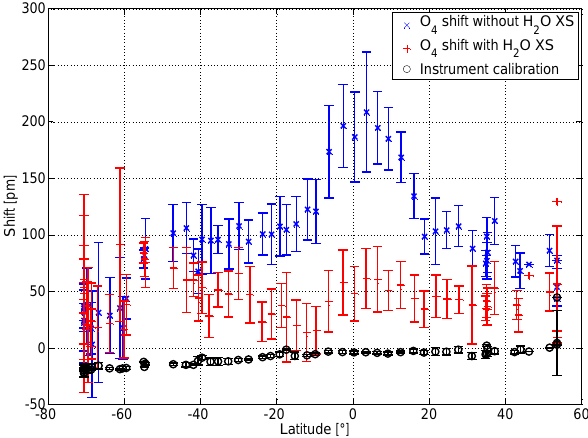
Figure 8. Error-weighted daily averaged DOAS-fit results for the shift of the O 4 cross section for measurements with a signal-to- noise ratio for the O 4 dSCD of more than 50. For this evaluation, the shift of the O 4 cross section was freely determined by the DOAS fit and not linked to the other absorption cross sections. Error bars de- note the standard deviation during 1 day. The shift of the instrumen- tal calibration was determined from the fit of the measured spectra to data from a convolved solar